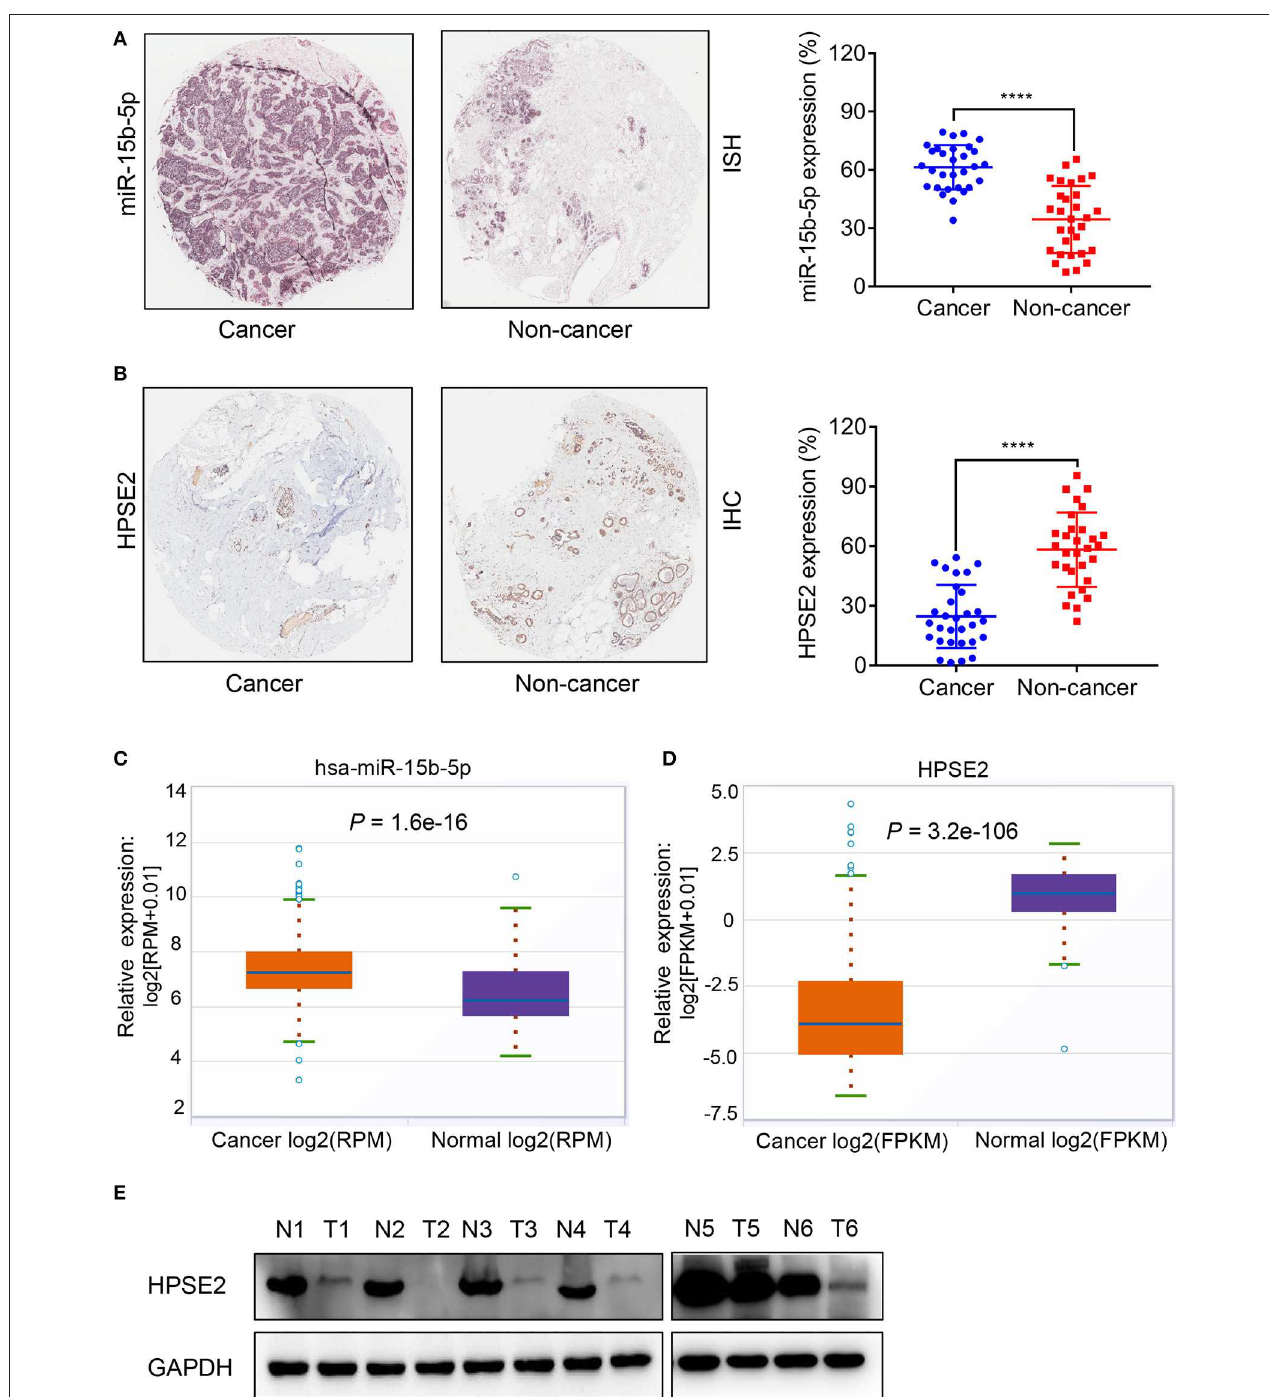
FIGURE 2 | Expression correlation analysis of miR-15b-5p and HPSE2 in breast cancer tissues and matched adjacent non-cancerous tissues. (A) In situ hybridization (ISH) demonstrating that miR-15b-5p in breast cancer tissues was higher than that in normal tissues ( n = 30, P < 0.0001). (B) HPSE2 immunoreactivity in breast cancer tissues was lower than that in normal tissues. The percentage of HPSE2 expression in breast cancer or normal tissues is shown in the figure ( n = 30, P < 0.0001). The patient population represented was from Outdo Biotech Co., Ltd. (Shanghai, China). (C,D) miR-15b-5p and HPSE2 expression in normal breast and breast cancer according to the TCGA data. (E) HPSE2 proteins have lower expression in breast cancer tissues. The HPSE2 levels in six human breast cancer and paired adjacent normal tissues were measured by western blot analysis. N, paired adjacent normal tissues; T, tumor tissues. Patient information is placed in the Supplementary Materials . (**** P <